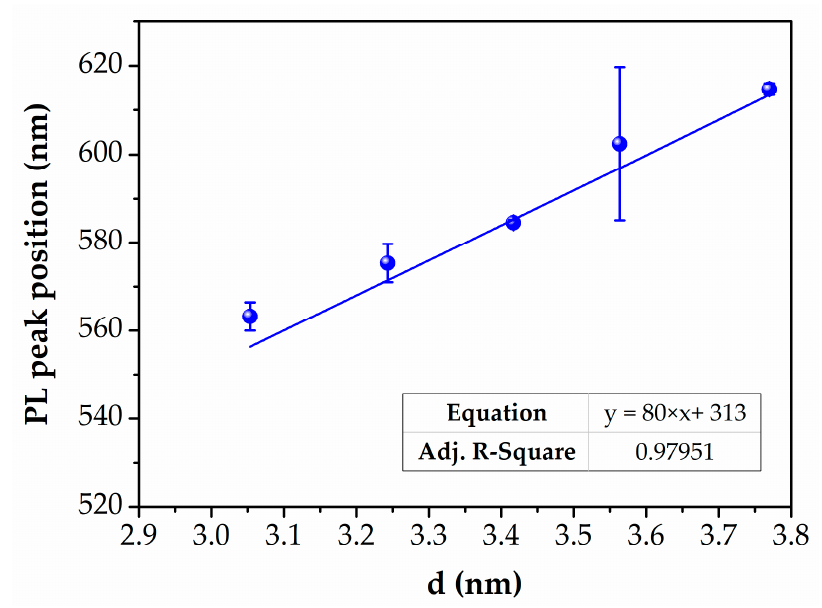
Figure 8. PL peak position as a function of CdTe QDs size grown in solution (the linear fit is reported as a solid line). as a solid